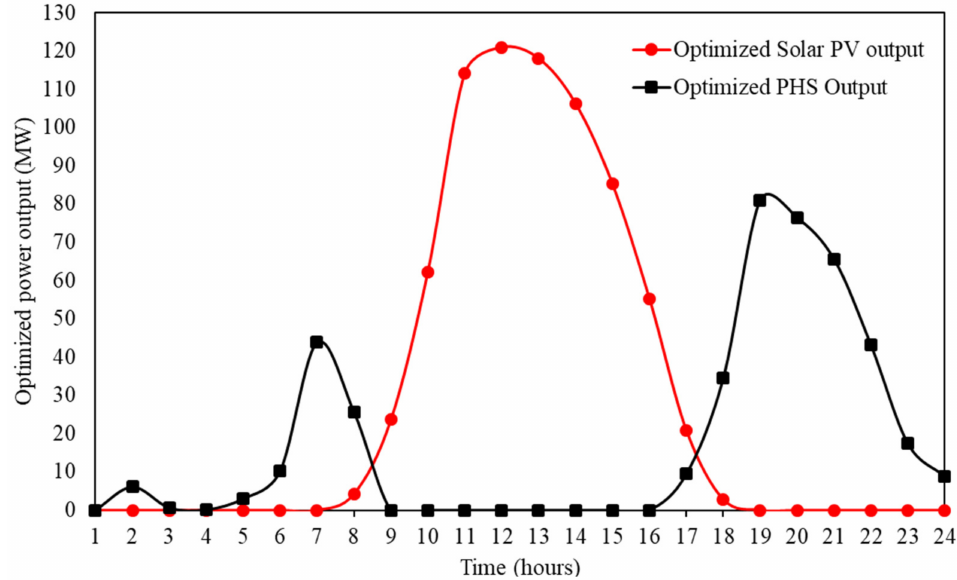
Figure 10. Optimized power output for both PV and PHS